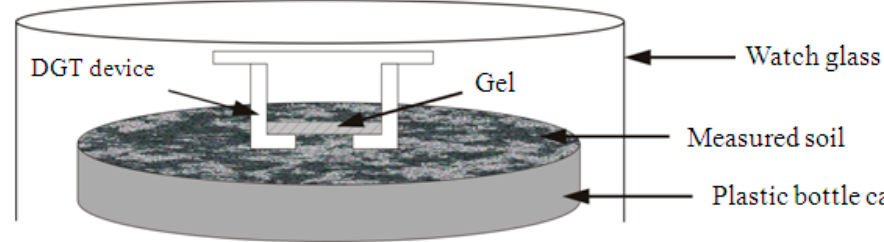
Figure 2. Schematic view of DGT deployment in soil.